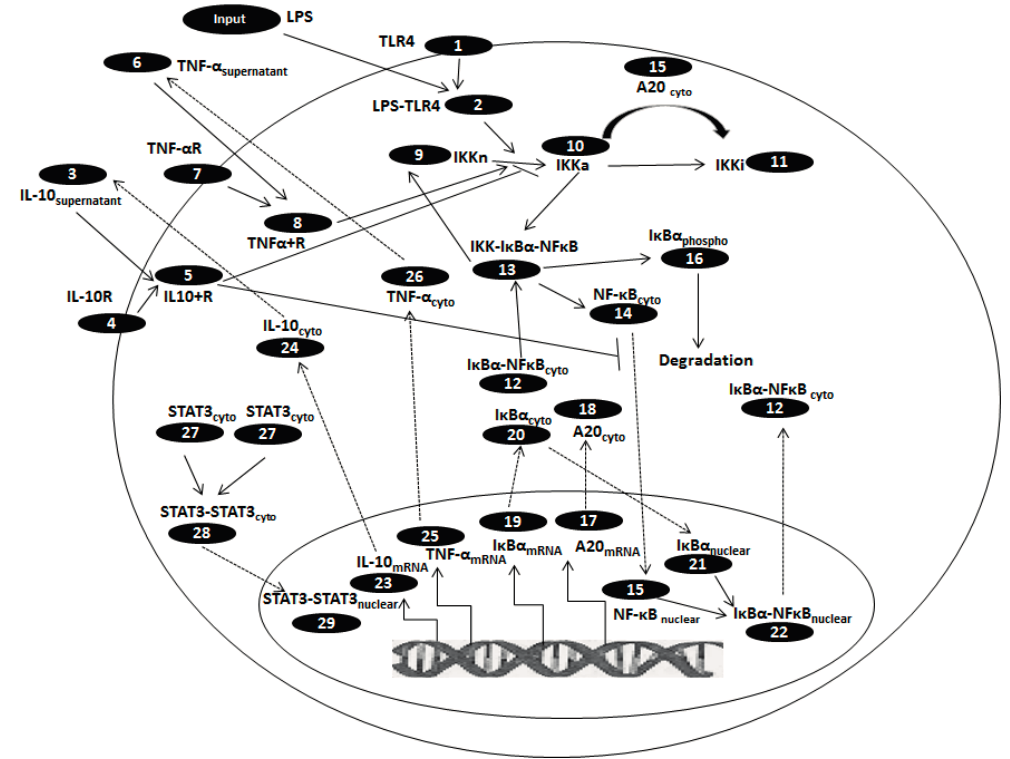
Figure 2. Implemented reaction network for the LPS-induced NF- κ B signal transduction pathway with TNF- α (positive) and IL-10 (negative) feedback